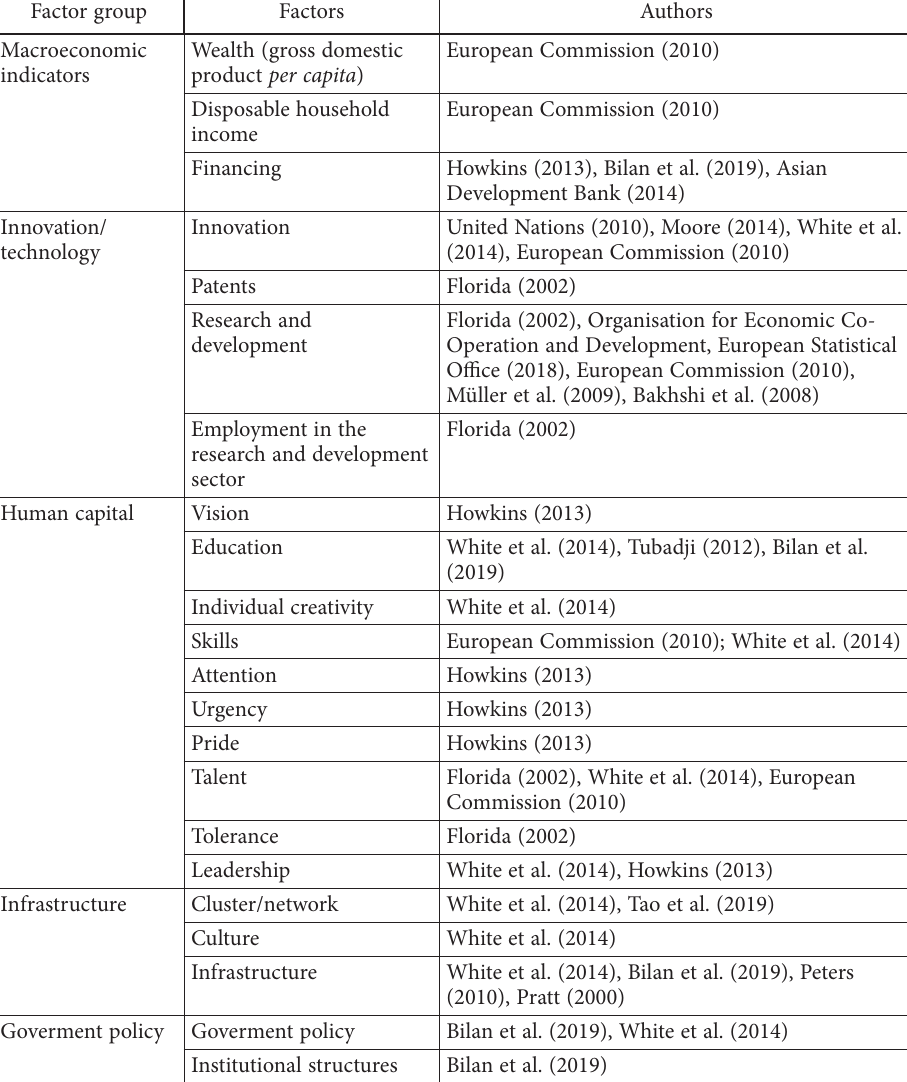
Table 1. Factors affecting the development of creative industries (source: created by authors) Factor